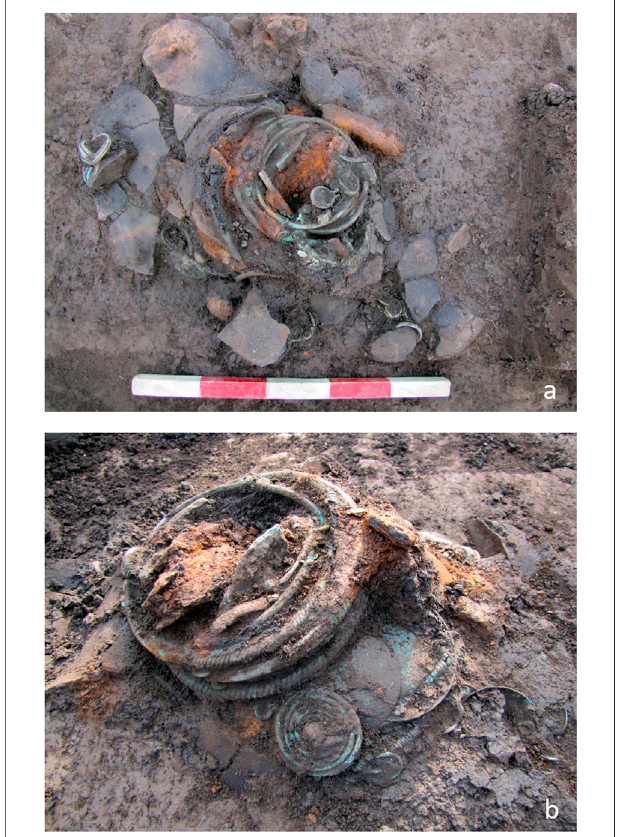
FIGURE 2 | Images illustrating the selected bronze adornment objects and their preservation